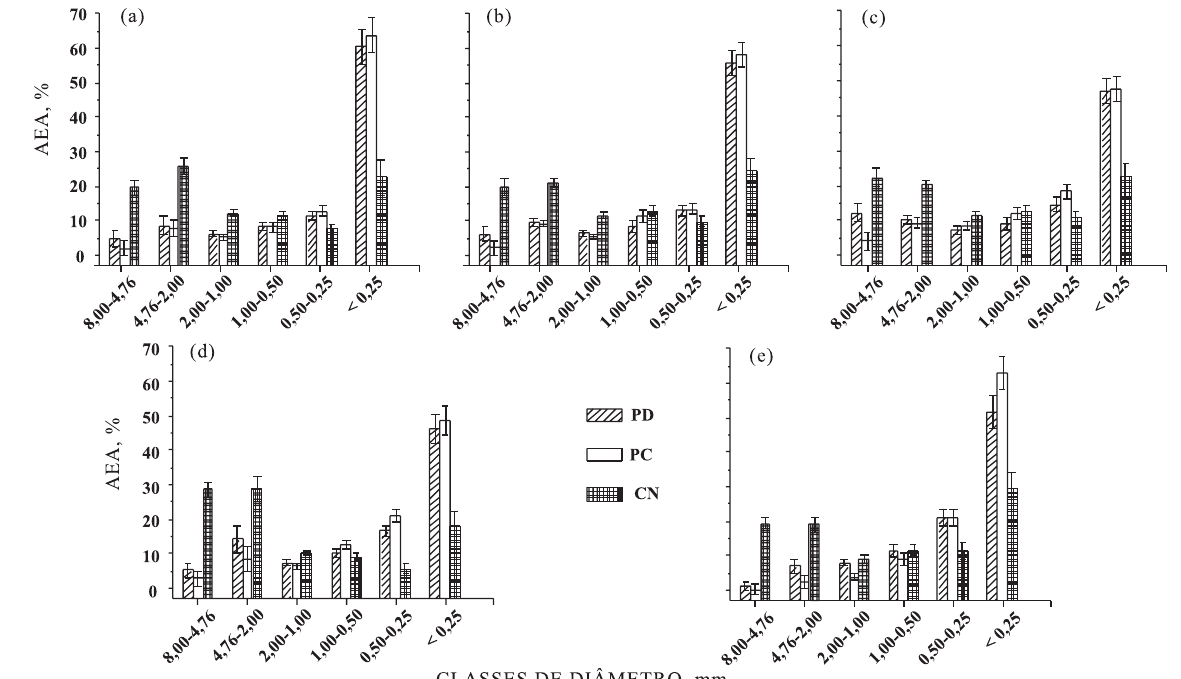
Figura 1. Agregados do solo estáveis em água (AEA) nas diferentes classes de diâmetro, nas camadas: (a) 0,000–0,025; (b) 0,025 a 0,075; (c) 0,075–0,125; (d) 0,125 a 0,175 e (e) 0,175 a 0,275 m de um Planossolo Háplico sob sistemas de manejo. PD: plantio direto, PC: preparo convencional, CN: campo nativo. Barras verticais indicam a diferença mínima significativa a 5 % em cada classe de agregados entre os sistemas de manejo do